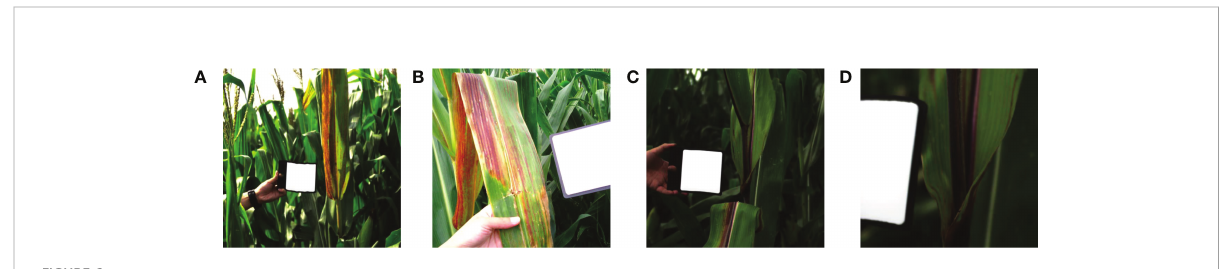
FIGURE 6 Four scenarios. (A) Scenario 1. (B) Scenario 2. (C) Scenario 3. (D) Scenario